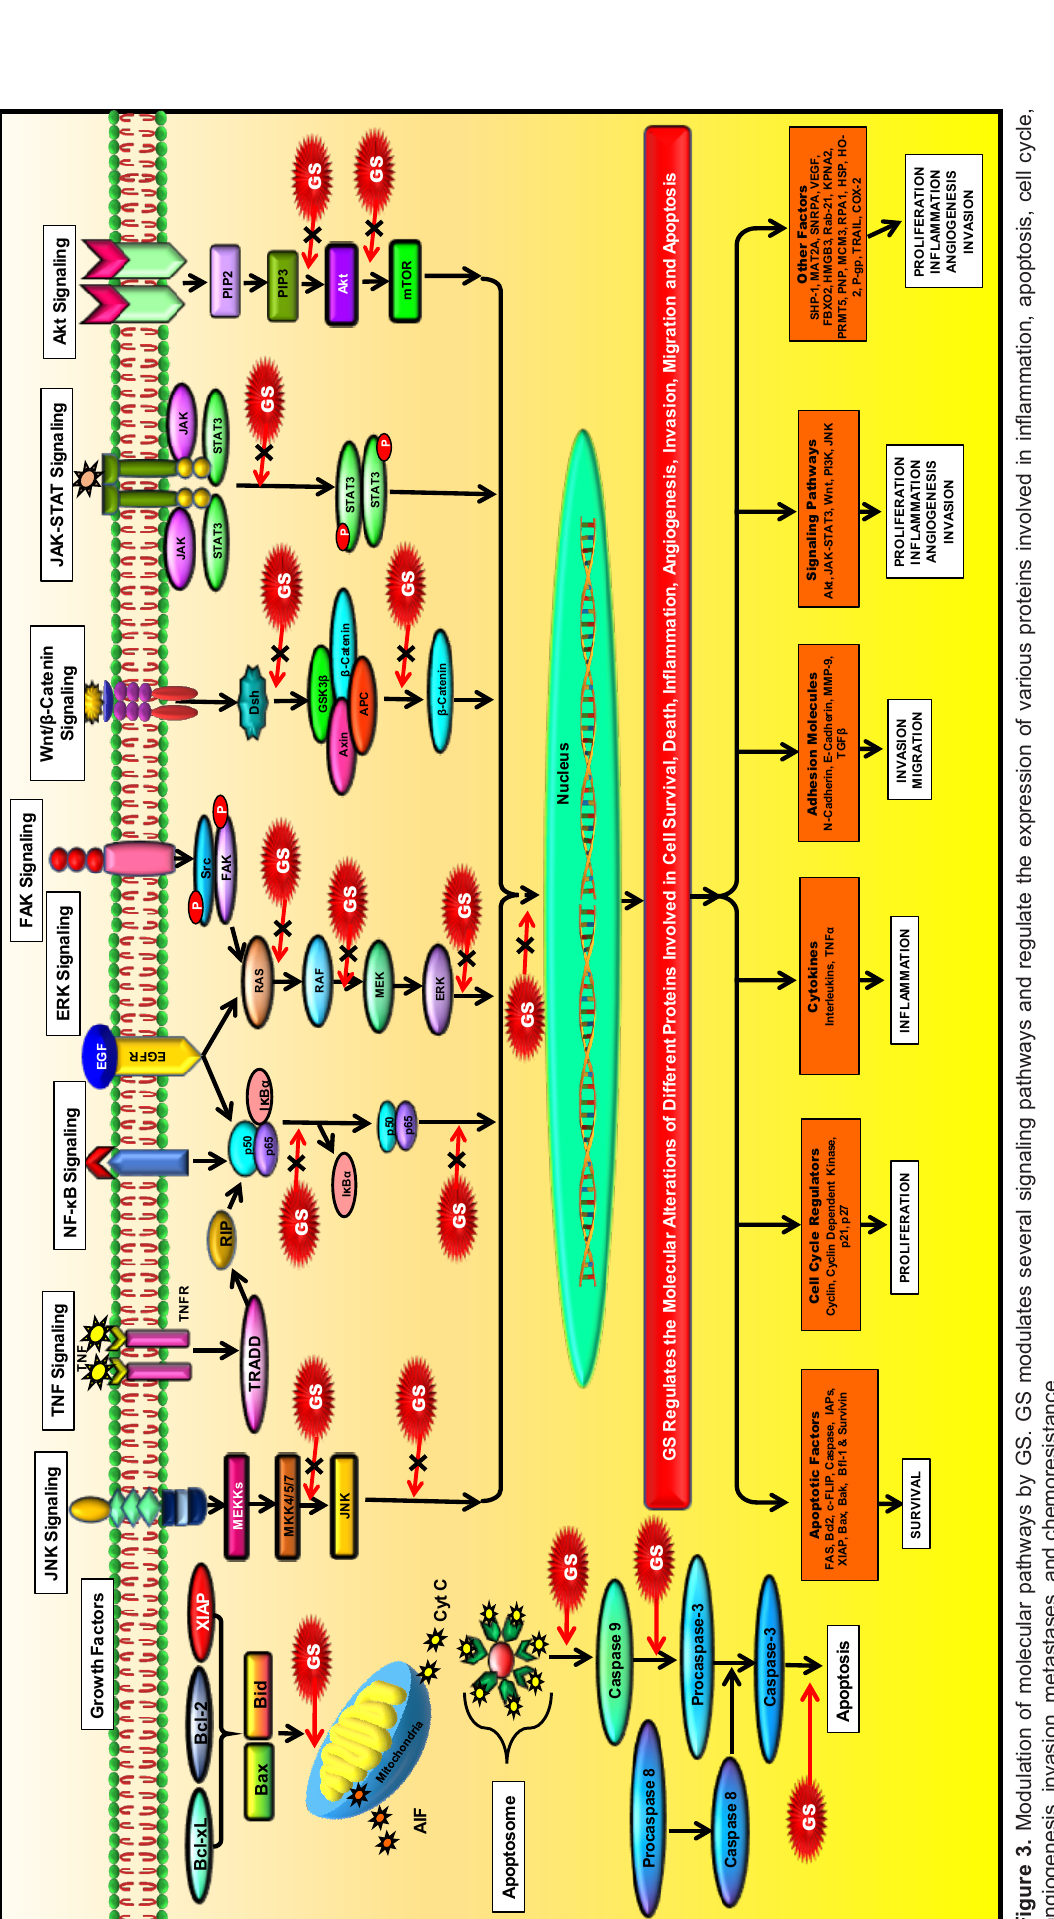
Explor Target Antitumor Ther. 2020;1:313-42 |